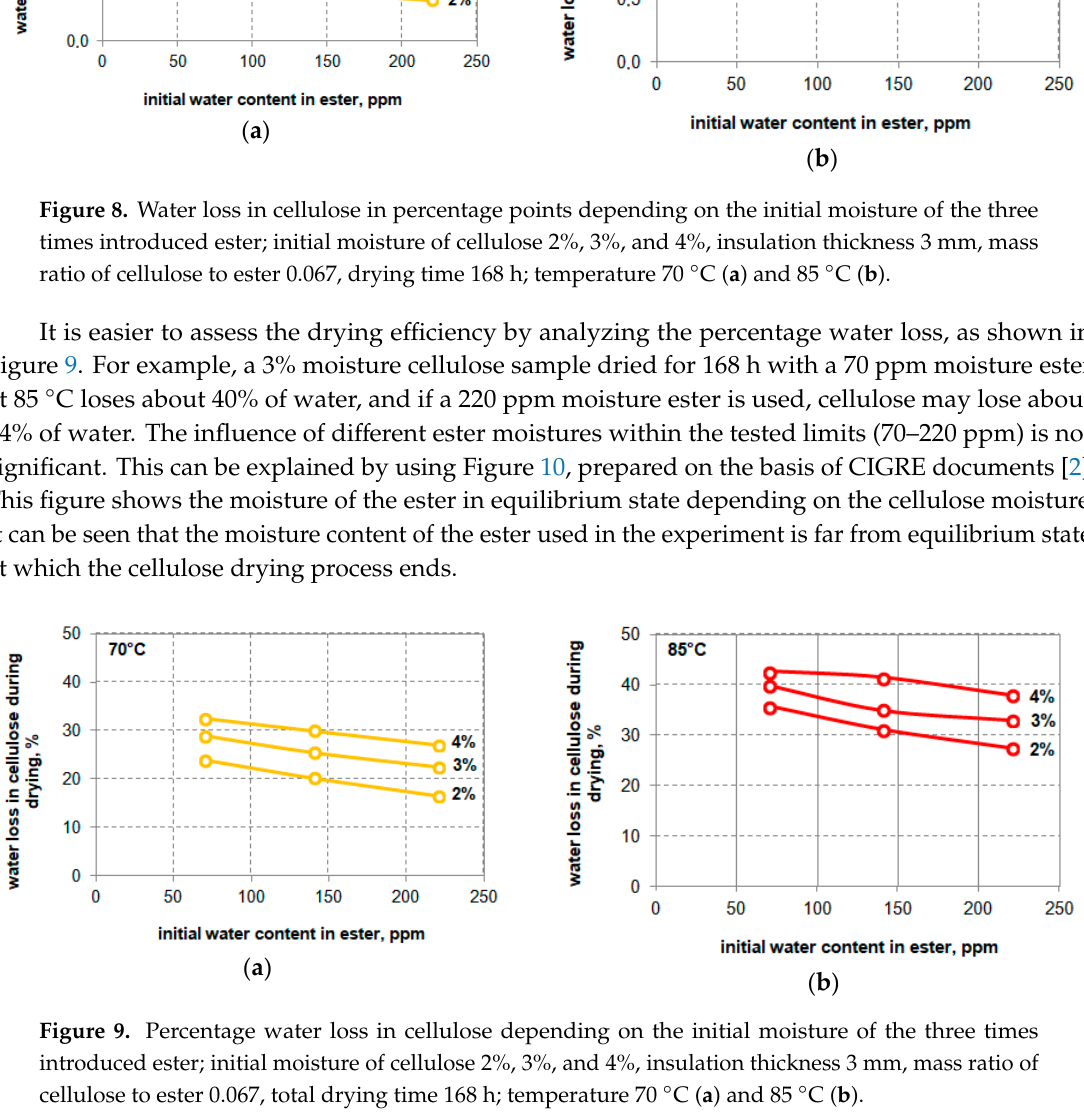
Figure 7. Water content in cellulose samples depending on drying time for three different values of initial moisture of cellulose; mass ratio of cellulose to ester 0.067, samples thickness 3 mm, temperature 85 °C; triple introduction of an ester with moisture content of 70 ppm.